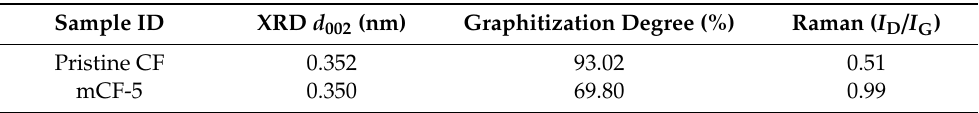
Figure 3. XRD patterns ( a ) and Raman spectra ( b ) of CF and modified CF-5. Table 2. XRD d-spacing values, graphitization degree and Raman I D / I G ratios of pristine CF and mCF-5,